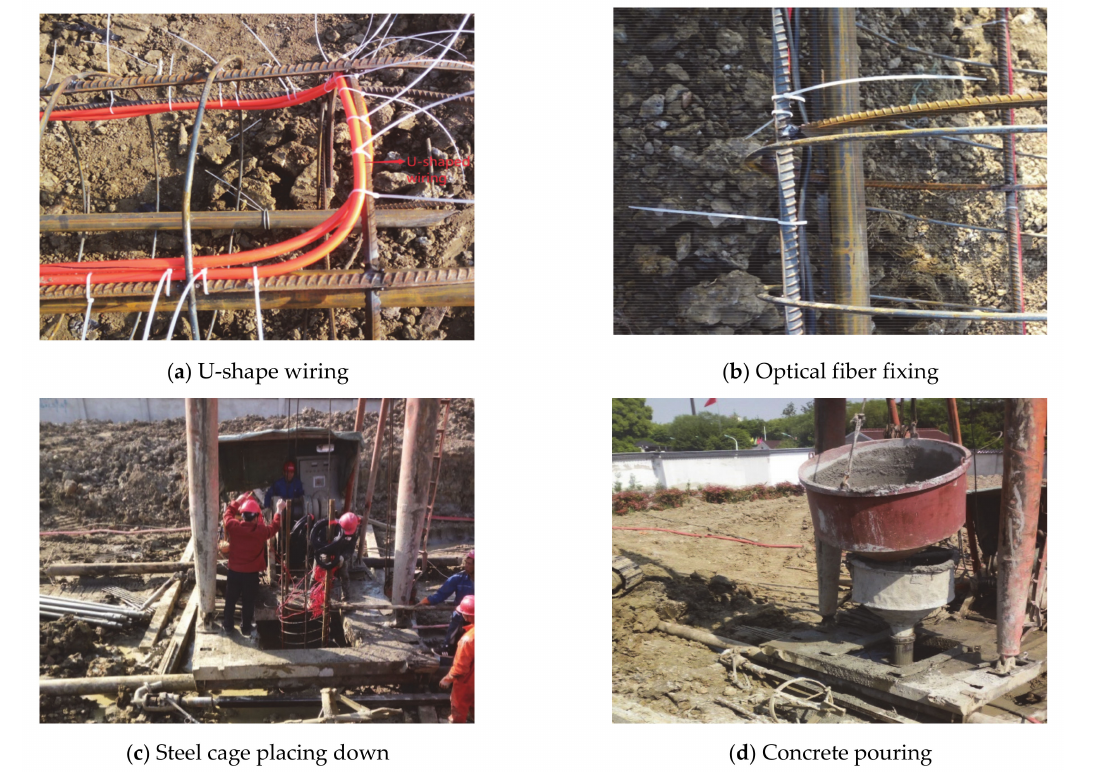
Figure 4. Sensor installed in the field.